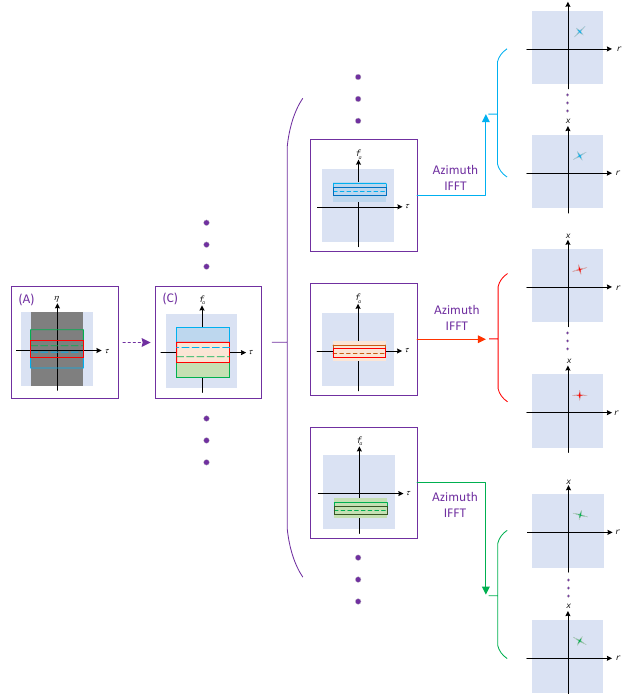
Figure 9. Time frequency diagram of generating multiple video frames. The different directions of the point targets in the image domain in the last column represent different observation times. Geometric correction is performed by default after azimuth IFFT. In particular, (A) and (C) correspond to those in Figure 8,